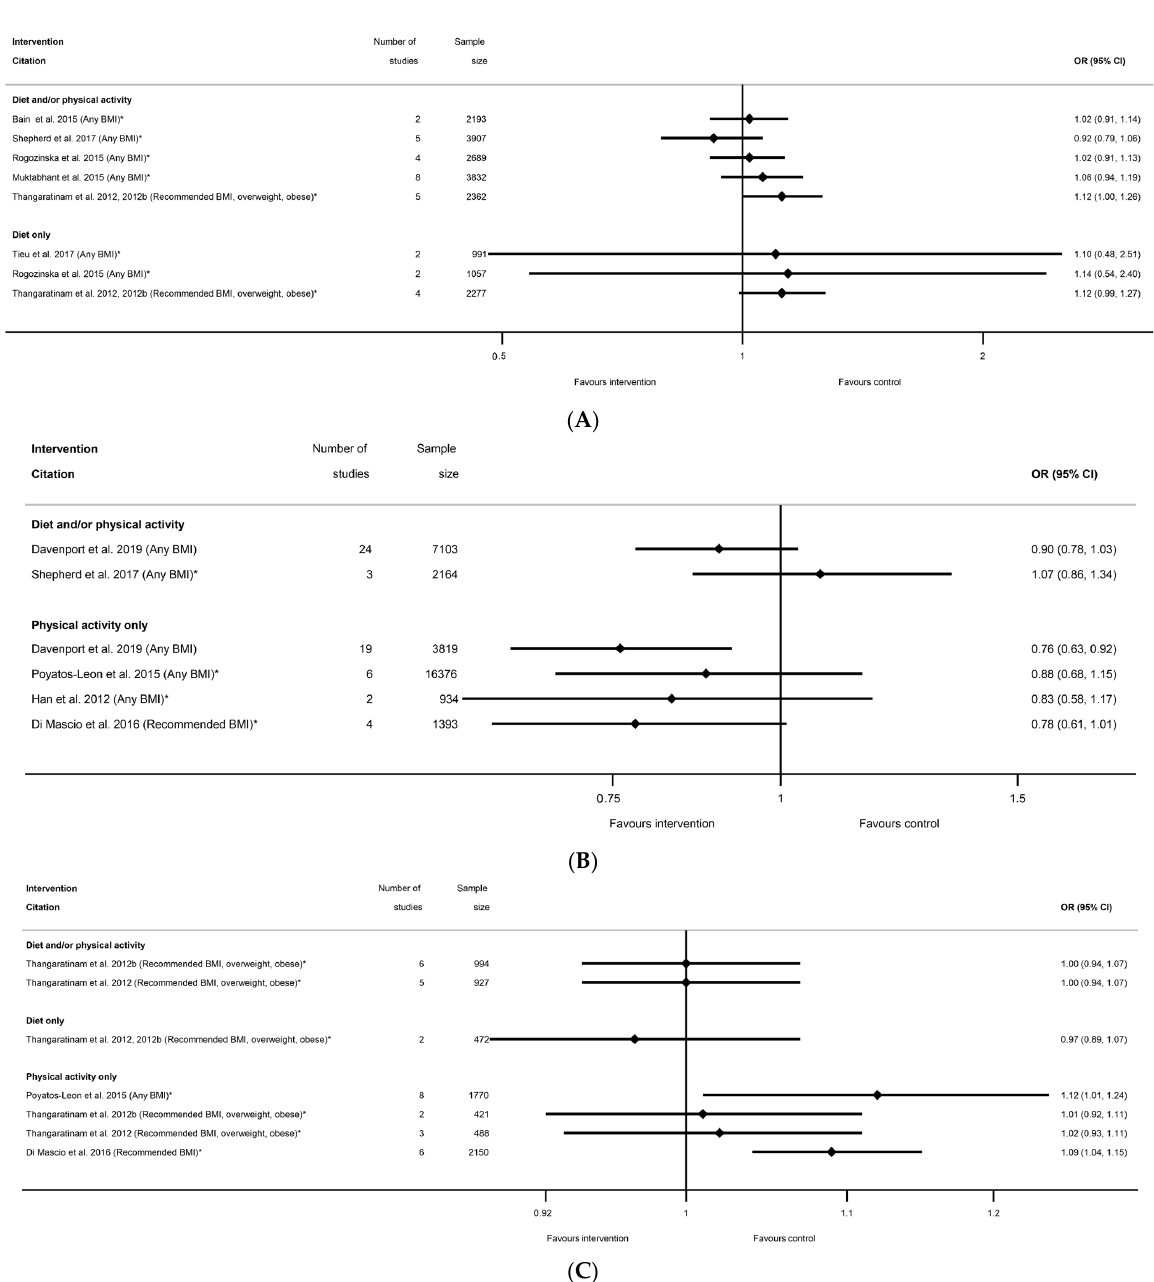
Figure 9. Forest plot of meta-analysis results for other modes of delivery; ( A ) Induction of labour, ( B ) instrumental vaginal delivery and ( C ) vaginal delivery. * indicates the estimate is relative risk.